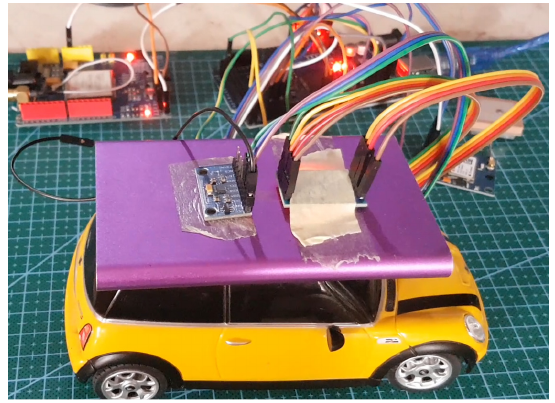
Figure 8. Testing accident with remote control car.